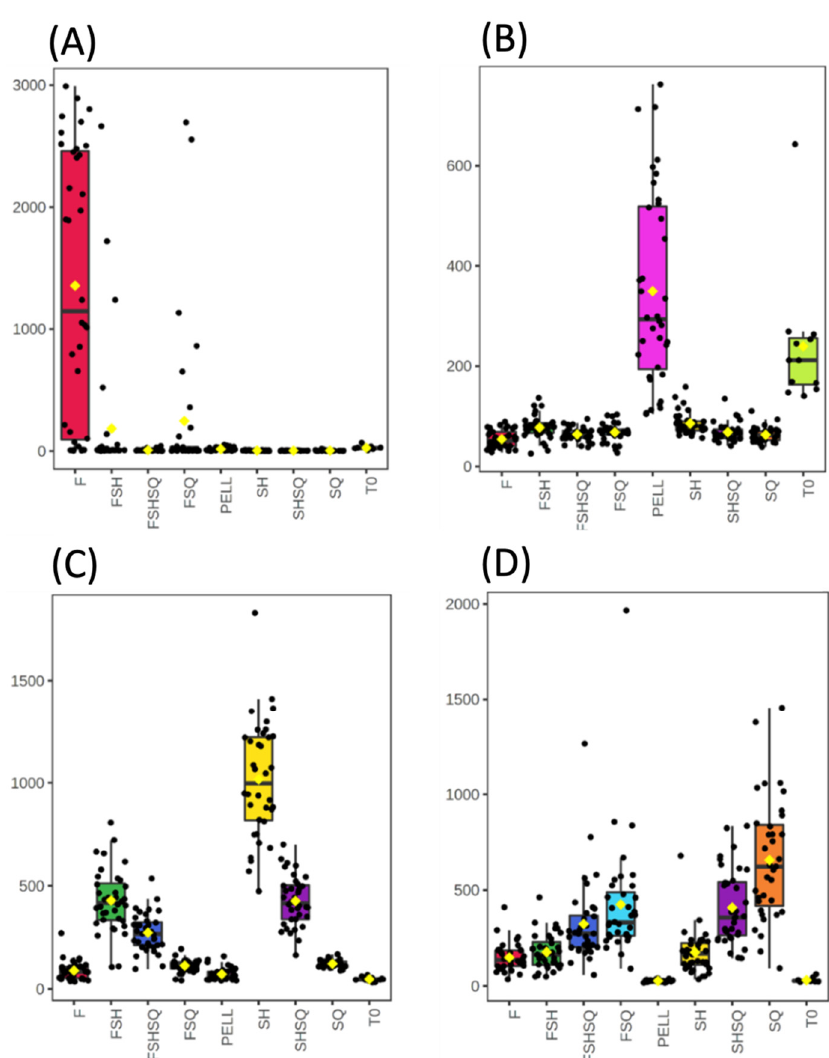
Figure 4. Box plots showing relative metabolite levels among the 8 diets (F, FSH, FSHSQ, FSQ, PELL, SH, SHSQ, SQ) and the conditioning diet (T0) measured in red drum liver extracts. ( A ) FIGLU; ( B ) beta-alanine; ( C ) γ -butyrobetaine; ( D ) sarcosine. F, fish diet; FSH, fish + shrimp diet; FSHSQ, fish + shrimp + squid diet; FSQ, fish + squid diet; PELL, pelleted commercial fishmeal-based diet; SH, shrimp diet; SHSQ, shrimp + squid diet; SQ, squid diet.